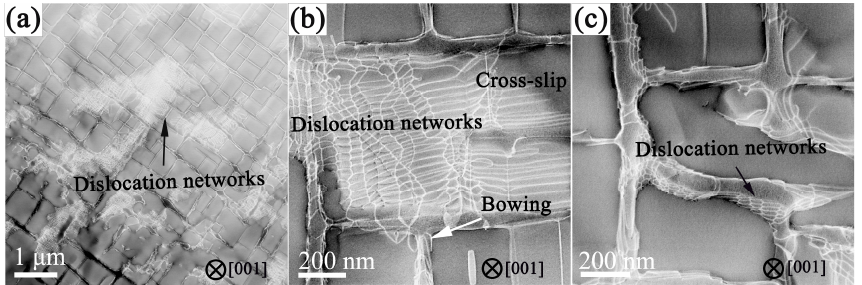
Figure 7. TEM-BF images showing dislocation configurations of an alloy at 980 °C under Δ ε t /2 = 0.8%: ( a ) distribution of the dislocations; ( b ) dislocation networks and bowing dislocations; and ( c ) formation of dislocation networks.